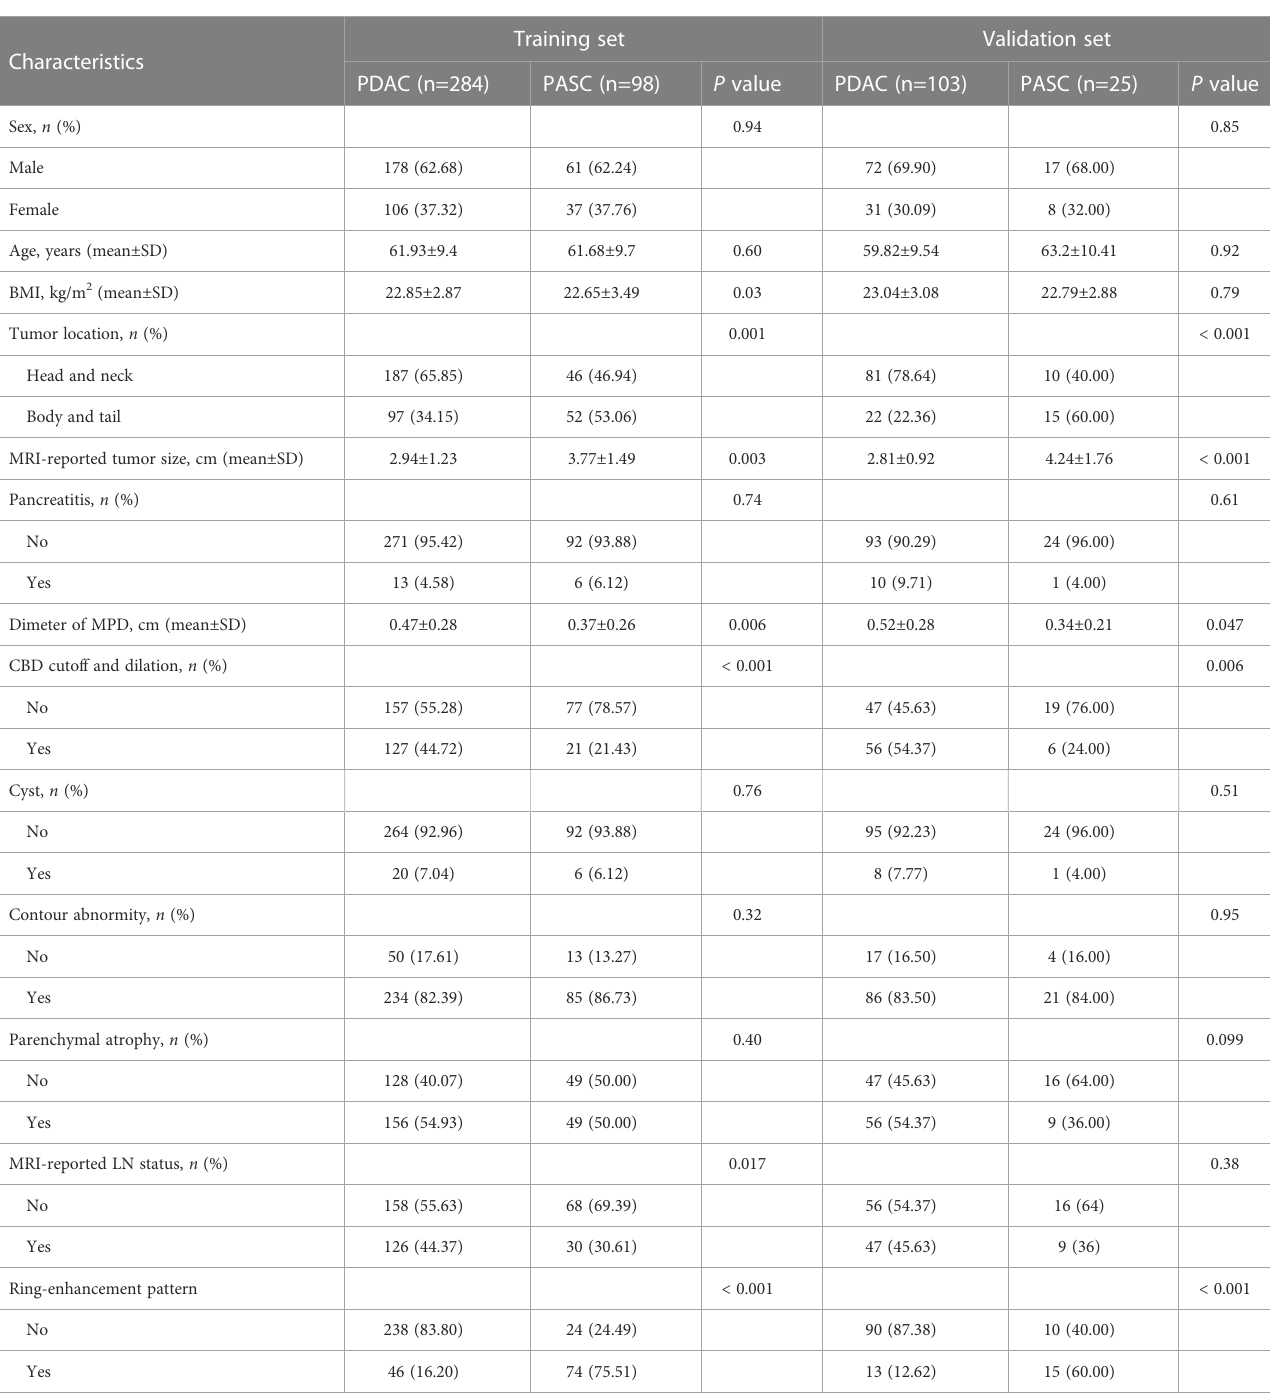
TABLE 1 Baseline characteristics of patients with PDAC and